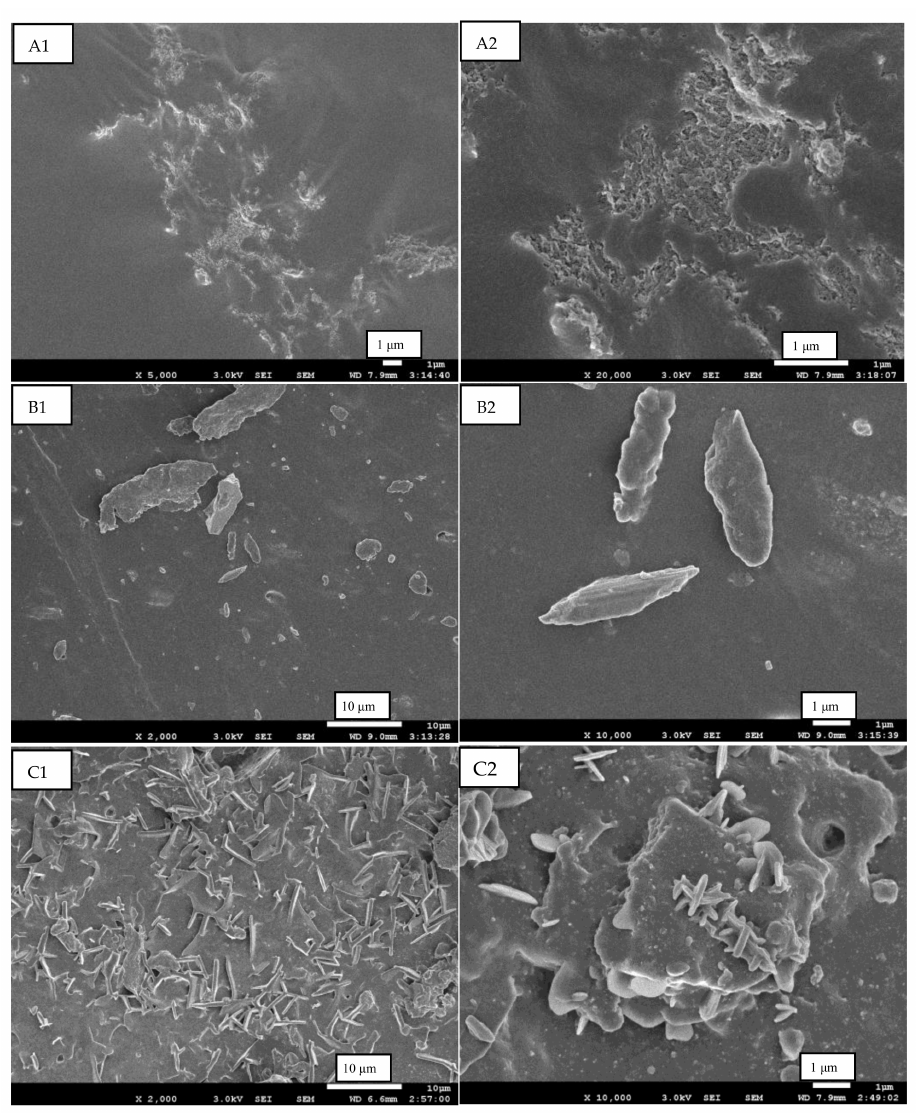
Figure 2. SEM images of the tensile fracture of RC/NR hybrids. ( A1 , A2 ): hybrid obtained by adding ethanol; ( B1 , B2 ): hybrid obtained by adding 5 wt% CaCl 2 aqueous; ( C1 , C2 ): hybrid obtained by adding glacial acetic